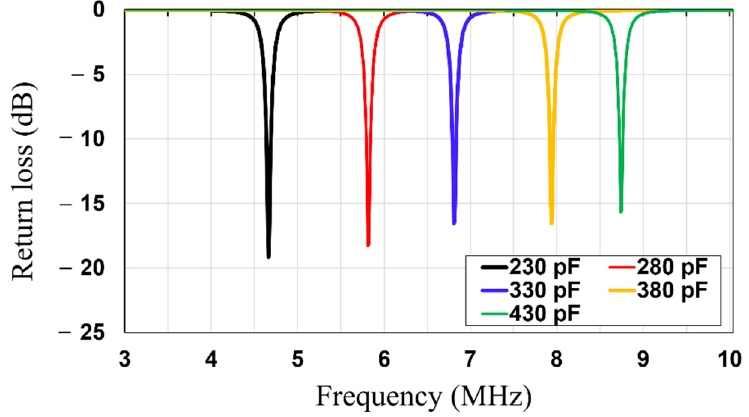
Figure 3. Simulated return losses of the Tx/Rx with the various capacitor values.